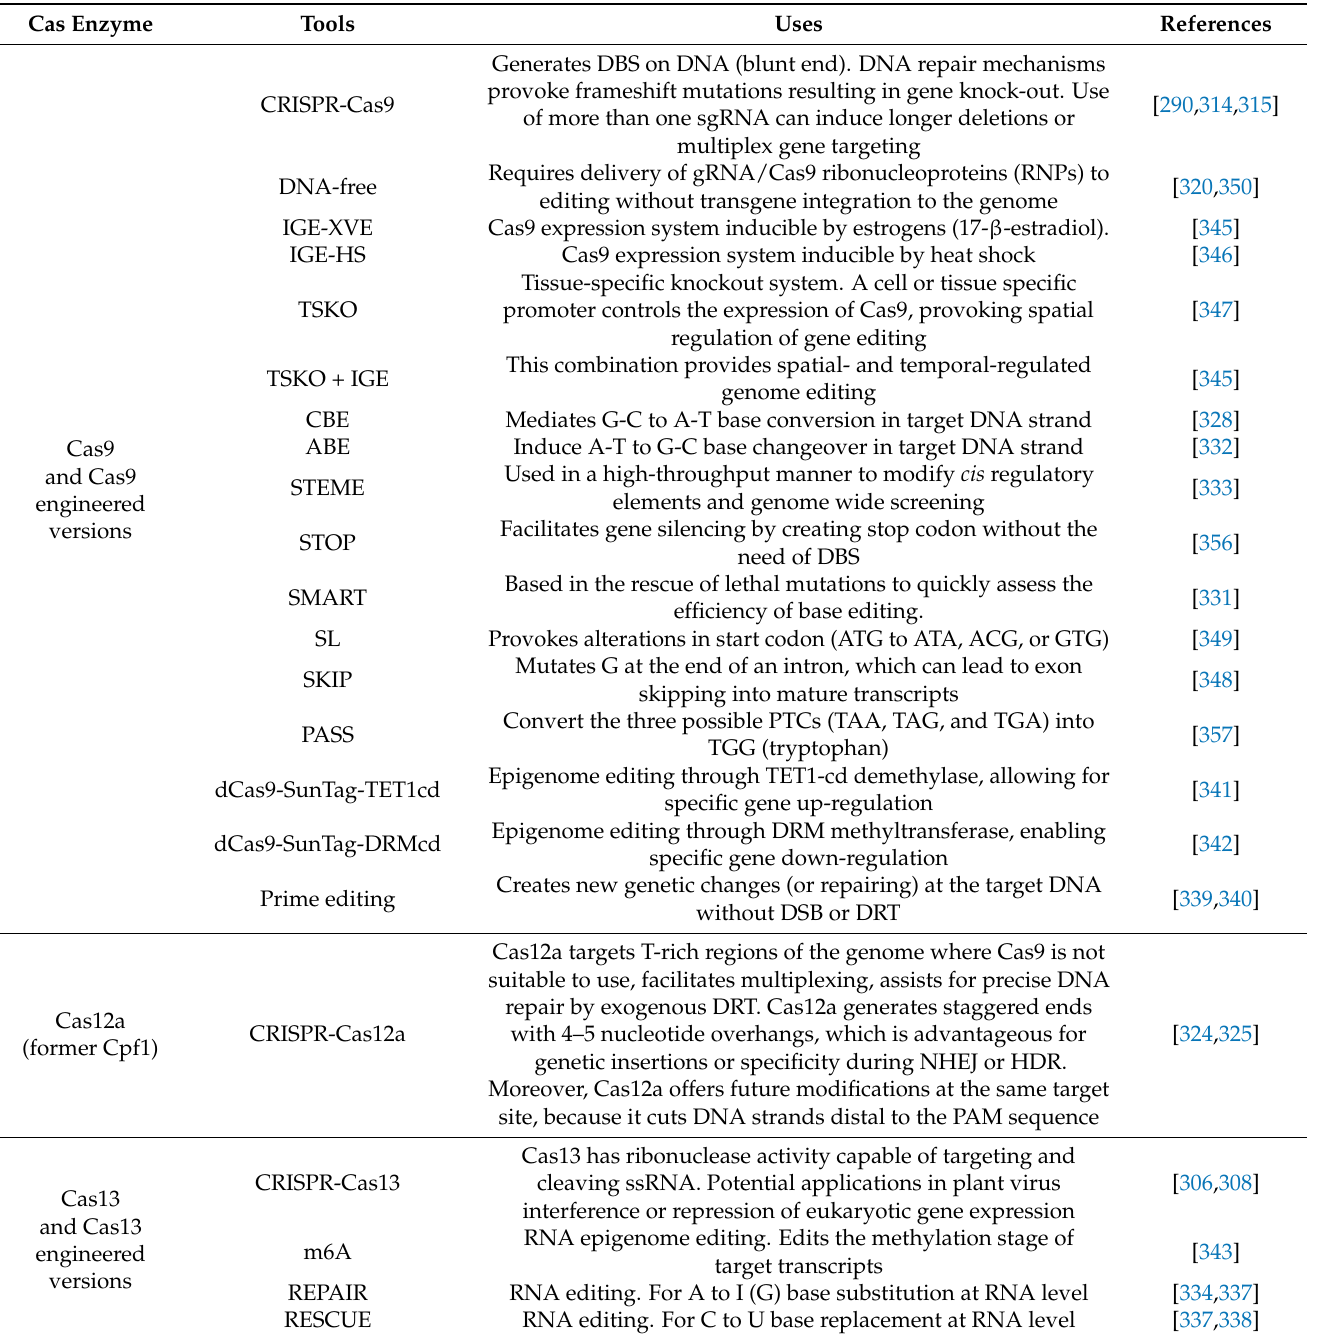
Table 1. Cas enzymes and CRISPR-Cas tools for plant genome